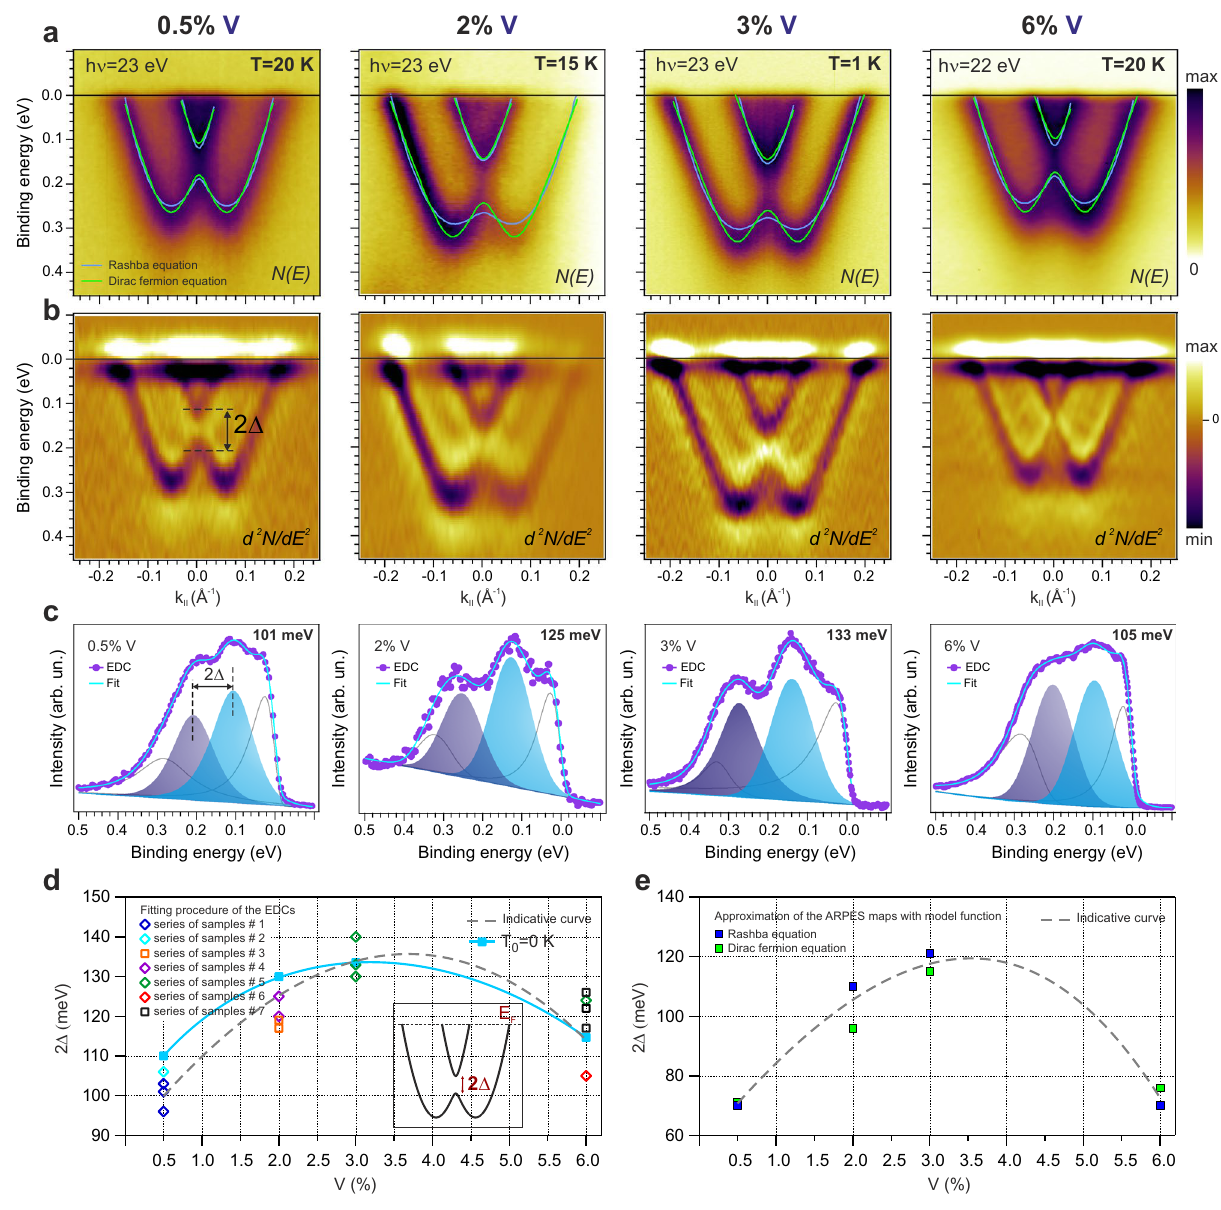
Figure 1. ( a ) ARPES dispersion relations N(E) for V-doped BiTeI with different concentration of V: 0.5% (T = 20 K), 2% (T = 15 K), 3% (T = 1 K) and 6% (T = 20 K) and their the second derivative d Approximations of the experimental Rashba bands with two model functions: Rashba equation (Eq. 1, blue curves) and Dirac fermion equation (Eq. 2, green curves) in ( a ). ( c ) The EDCs cut at the Ŵ point ( k � = 0 Å − with the decomposition into spectral components. The components corresponding to the Rashba parabolas states at the KP gap is shown in blue and purple color. Dependence of the KP gap value ( 2 (cid:31) ) on V concentration (0.5, 2, 3 and 6 %) measured for the series of samples (see details in “Methods” section) derived from the EDC analysis ( d ) and model functions approximation ( e ). The dash lines show the non-monotonic dependence of the KP gap averaged over all measurements for each V concentrations as guide for the eye in ( d , e ). The schematic presentation of the measured parameter, namely the KP gap size 2 (cid:31) , is shown in inset of ( d ). Solid blue line in ( d ) shows the KP gap size dependence at T = 0 K, estimated under the assumption of the surface Curie temperature of about 130